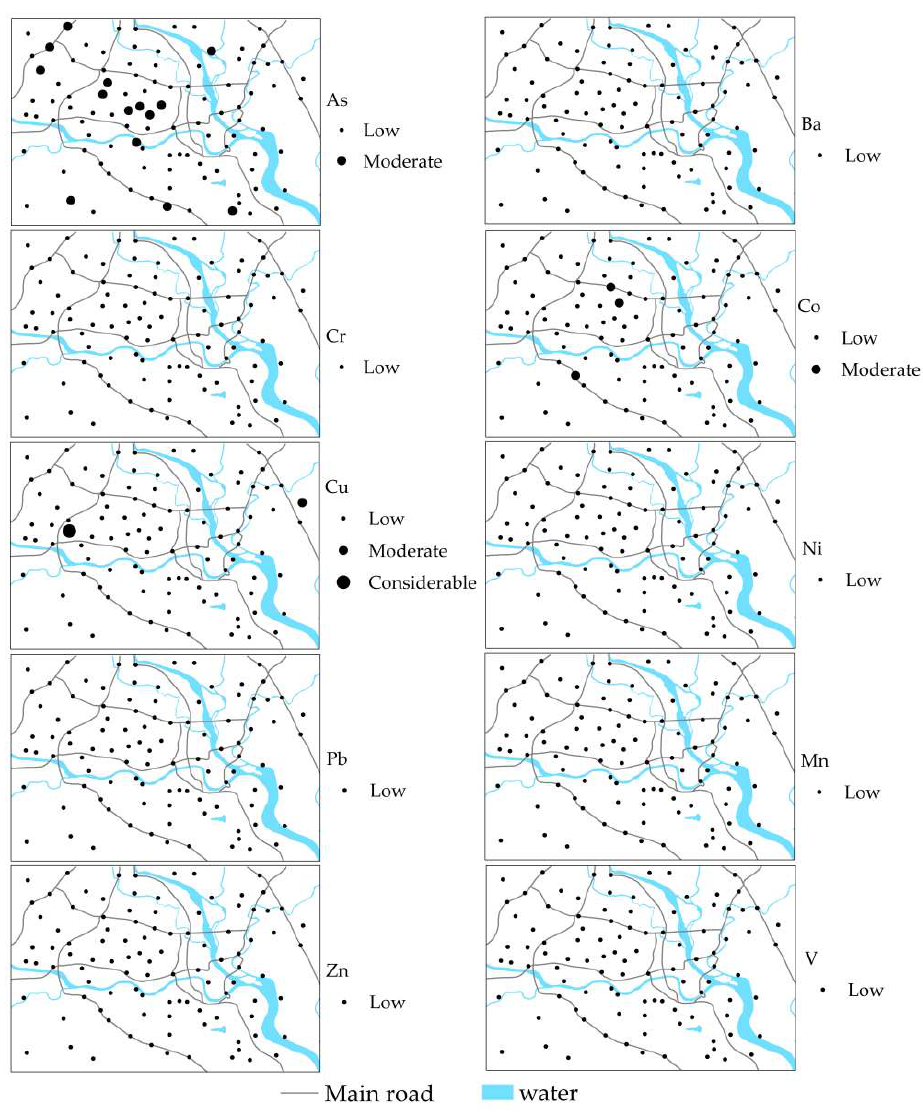
Figure 4. The E i degree of HMs in Mianyang urban area.